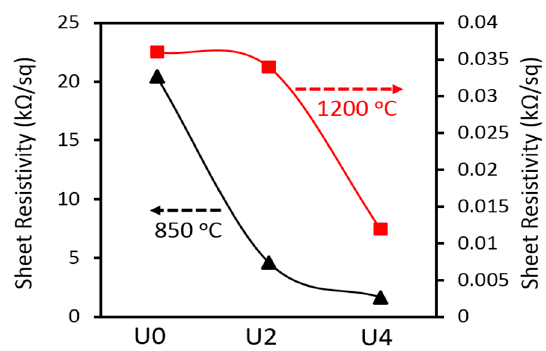
Figure 9. Sheet resistance for samples of U0, U2 and U4 at different carbonisation temperatures.